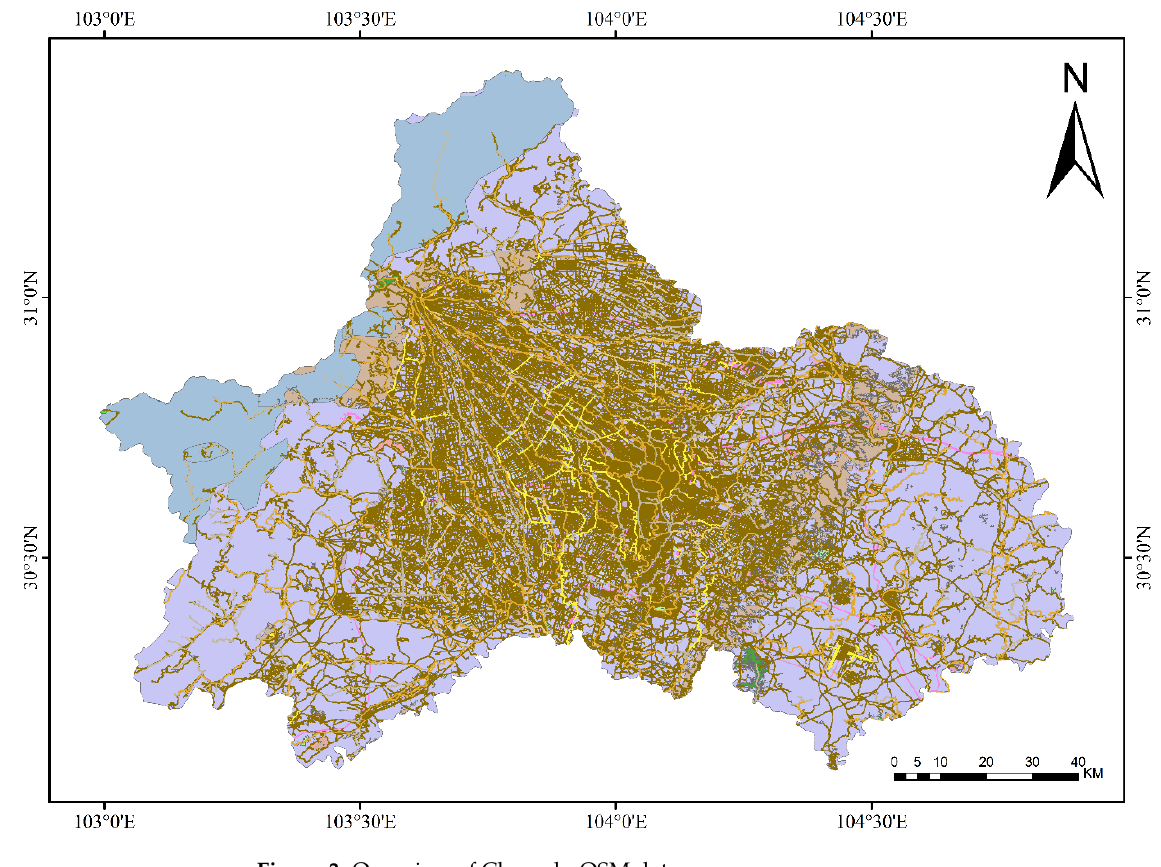
Figure 3. Overview of Chengdu OSM data.